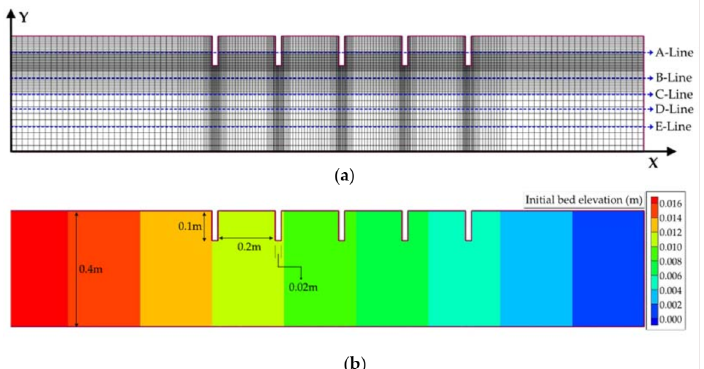
Figure 7. Computational domain of the experimental case: ( a ) computational mesh (63 × 337 grid) and ( b ) initial bed elevation and layout of multiple spur